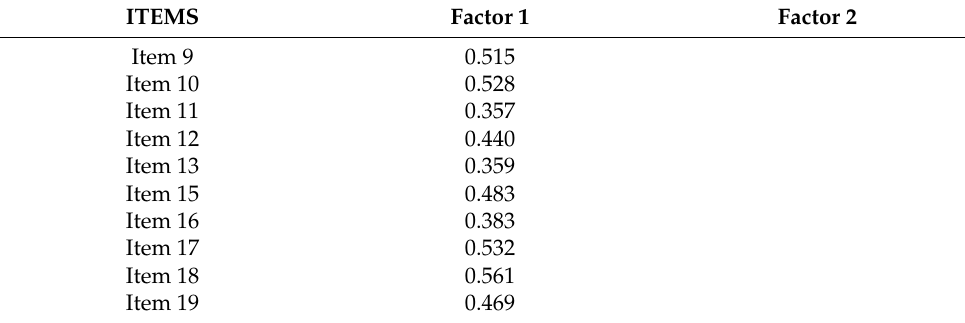
Table 1. Matrix of rotated